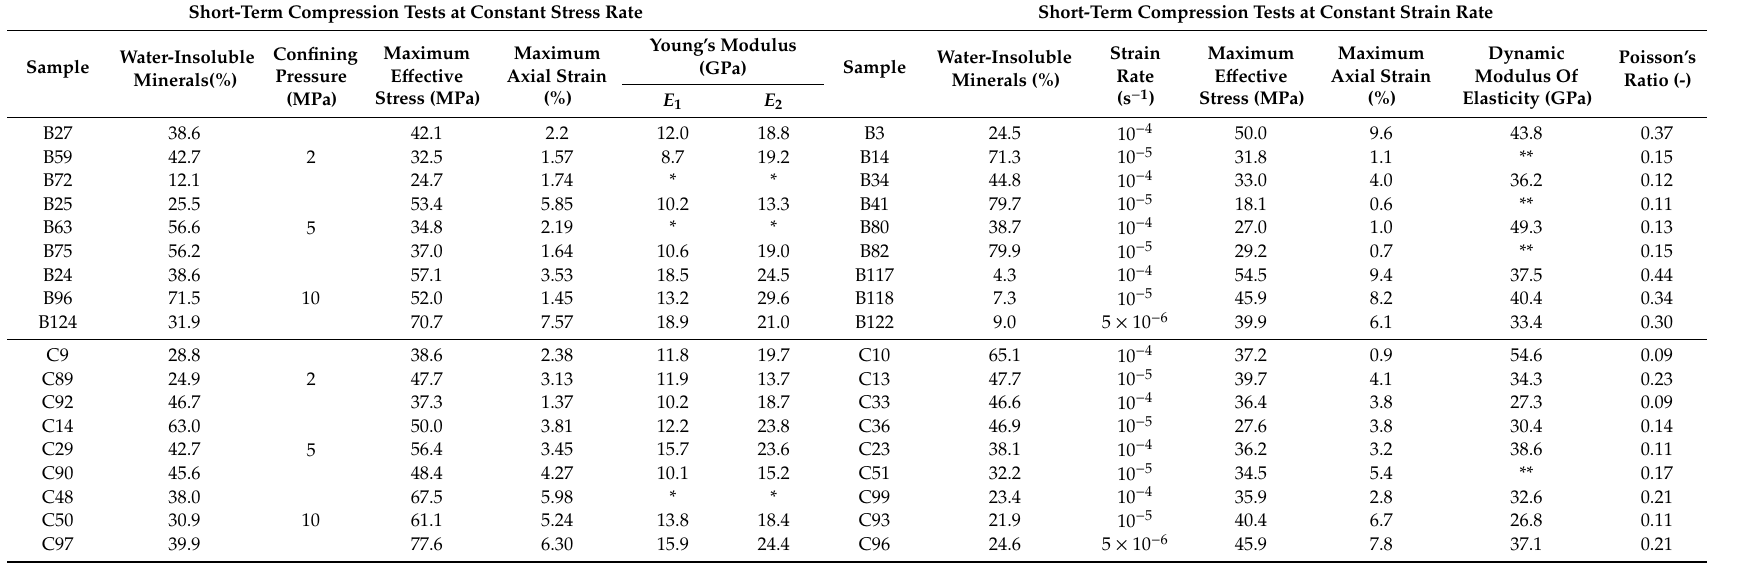
Table A1. Results of short-term compression tests of the Brown and Red Zuber unit samples (according to [57,58,62]).